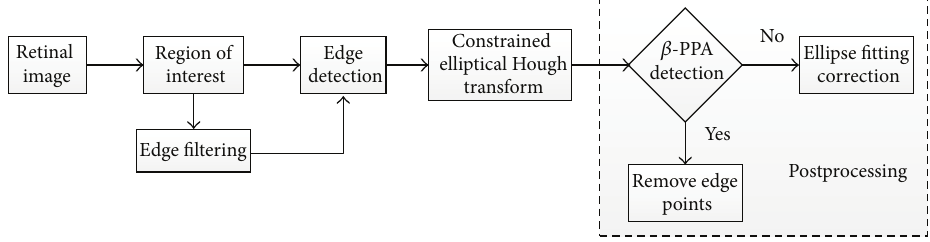
Figure 15: Flowchart for algorithm proposed in